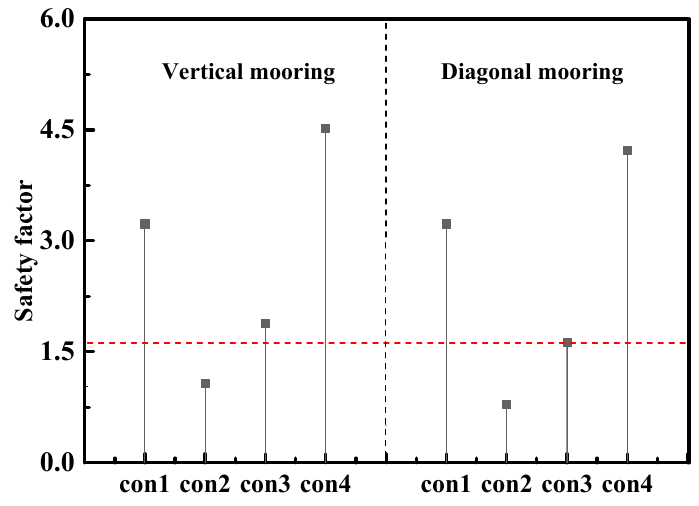
Figure 8. Statistics of tension in mooring lines under different mooring configurations. The safety factor of mooring lines under different mooring configurations is shown in Figure 9. It can be seen that only Configuration 2 cannot meet the specification requirements.